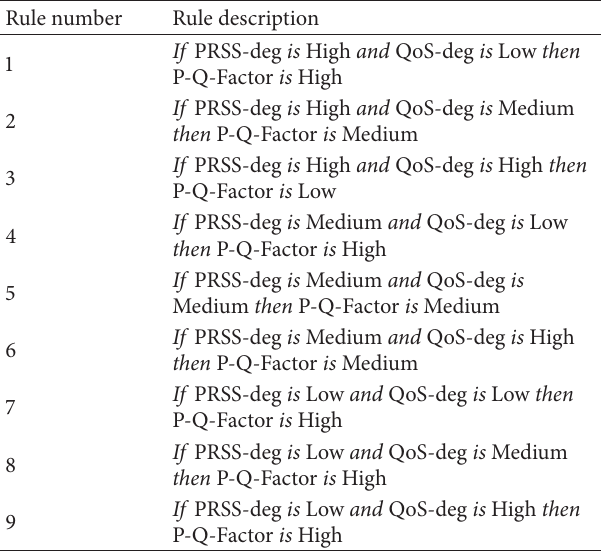
Table 6: Inference rules for